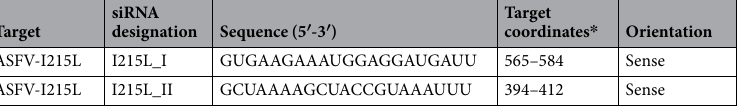
Table 2. siRNA sequences to knockdown ASFV-I215L transcripts. * siRNA coordinates according to the relative position in gene nucleotide sequence (start at position 1,